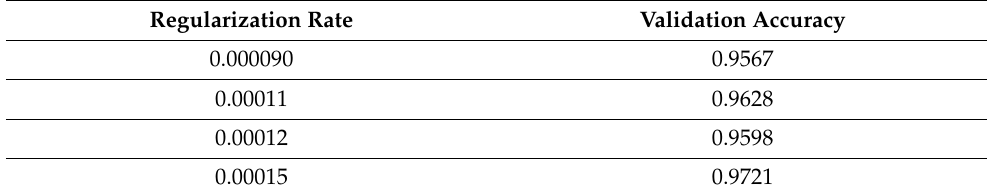
Table 10. Regularization